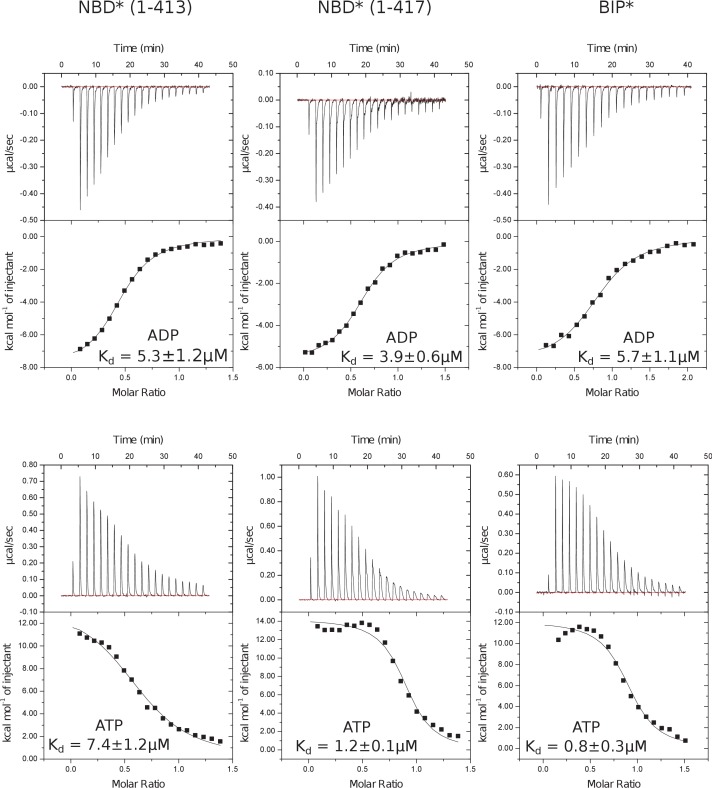
Representative panels showing nucleotide (ATP or ADP) binding to BiP* and isolated NBD*(1-413) and NBD*(1-417) measured by ITC. Experiments were performed at 25°C using 20–80 μM protein in the cell and 0.1–0.4 mM ADP (or ATP) injected from the syringe. The top panels show raw data and the bottom panels show integrated normalized data.